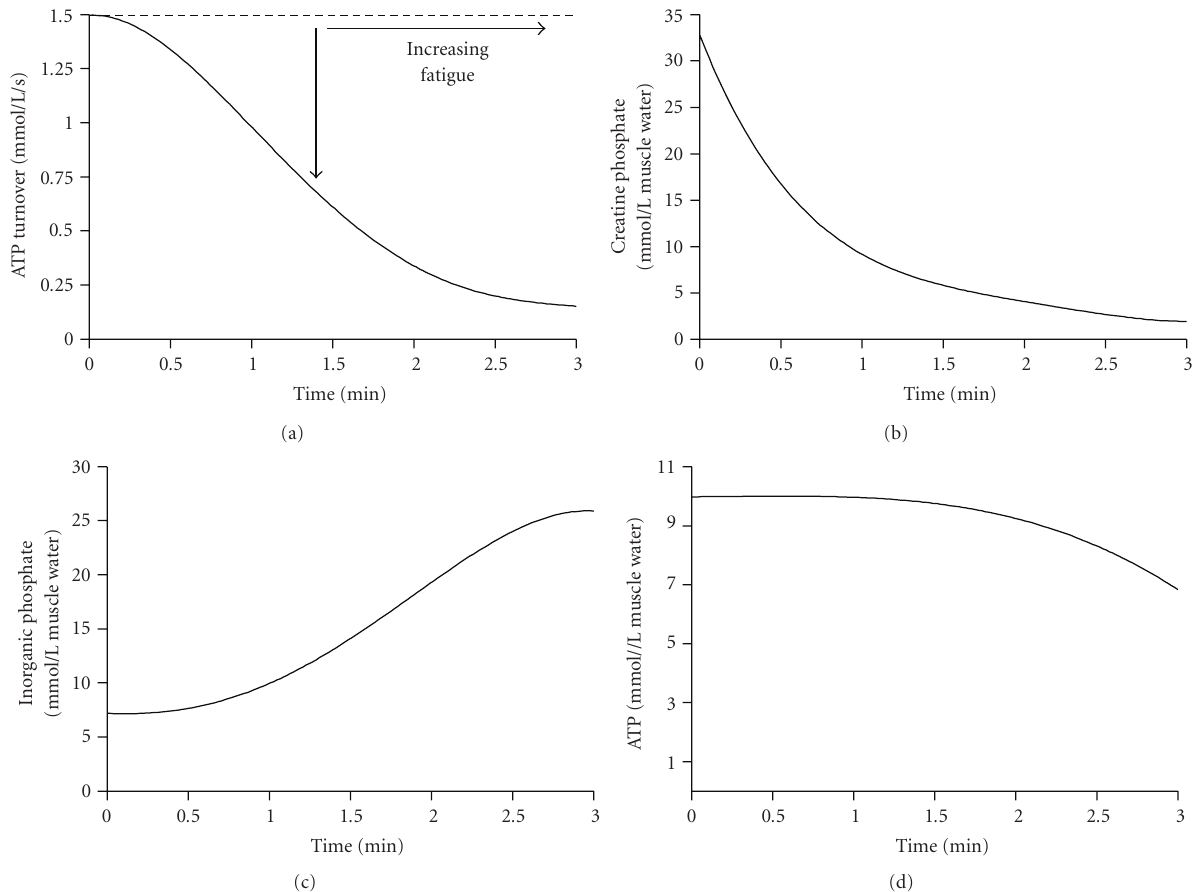
Figure 1: Stack plots of the change in (a) ATP turnover and key phosphagen system metabolites during 3 minutes of intense exercise to volitional exhaustion. (b) Creatine phosphate, (c) inorganic phosphate, and (d) ATP. Note the well maintained preservation of muscle ATP for most of the duration of the exercise bout.